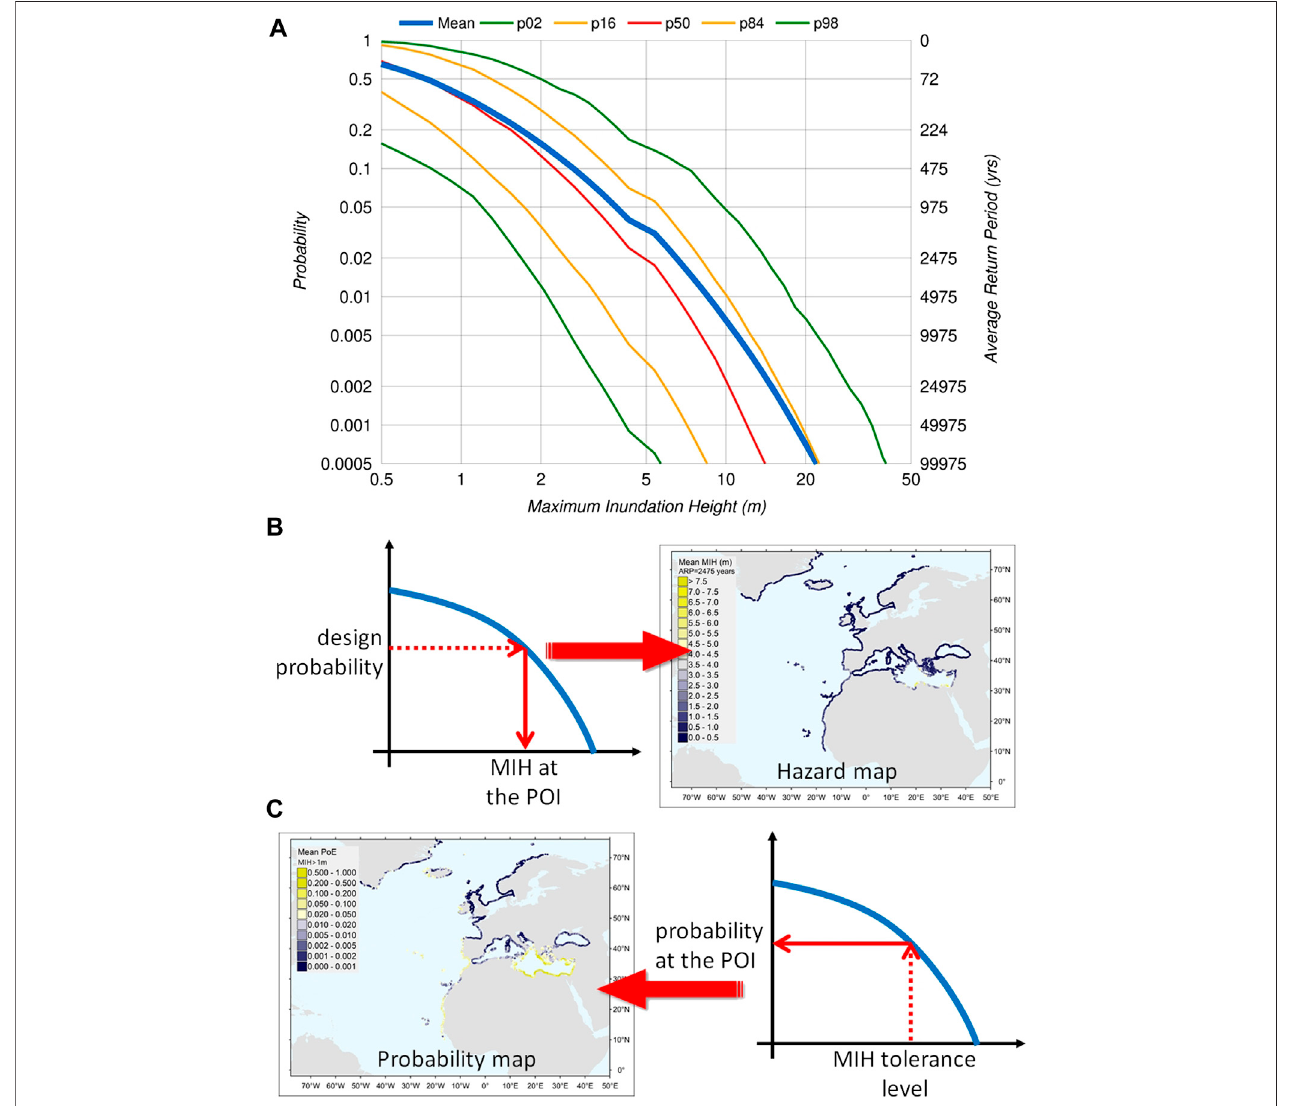
FIGURE 10 | (A) Example of an ensemble of hazard curves calculated for a point of interest. Each curve represents a different percentile of all the models spanning the epistemic uncertainty. (B) Hazard map ( Figure 11A ) produced to show the values of the maximum inundation height (MIH, in meters) at any point of interest (POI), obtained by cutting hazard curves at a given design probability of exceedance in 50 years. (C) Probability map ( Figure 11A ) produced to show the probability of exceedance in 50 years at any point of interest, obtained by cutting hazard curves at a given tolerance level of the maximum inundation